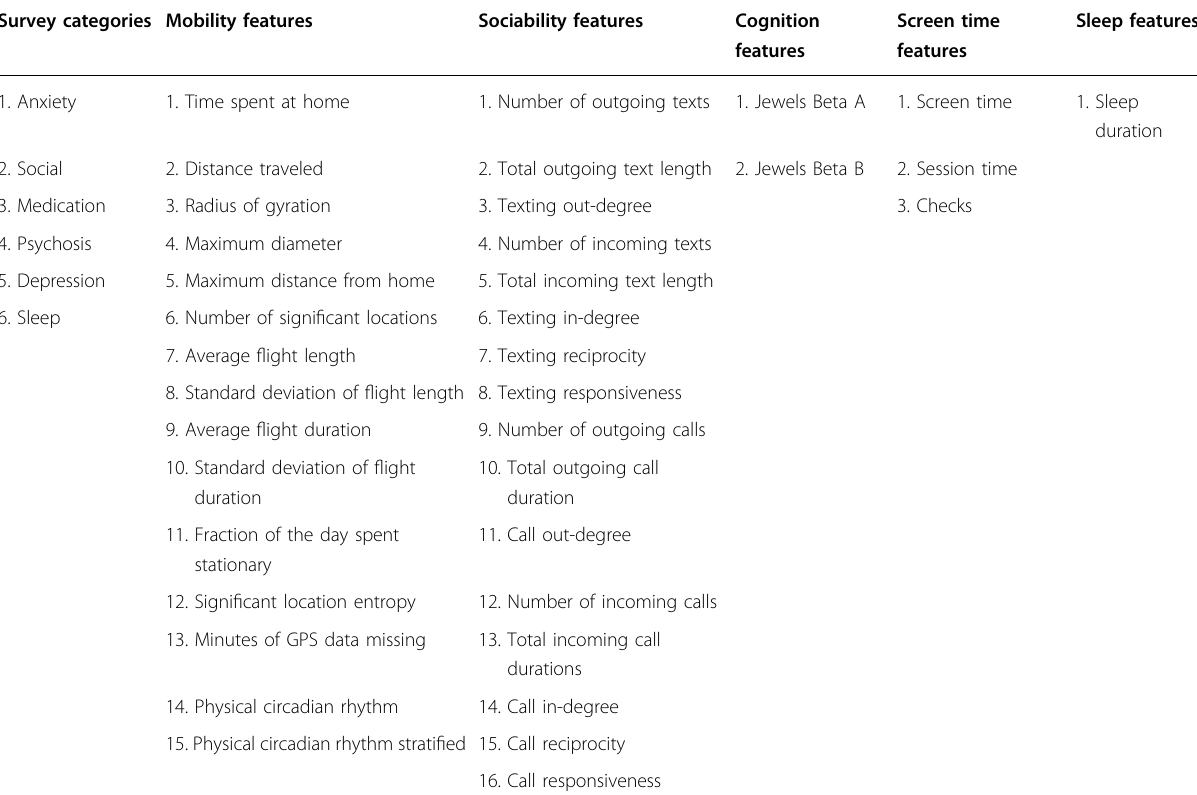
Table 1 Listing of features within feature groups. Survey categories Mobility